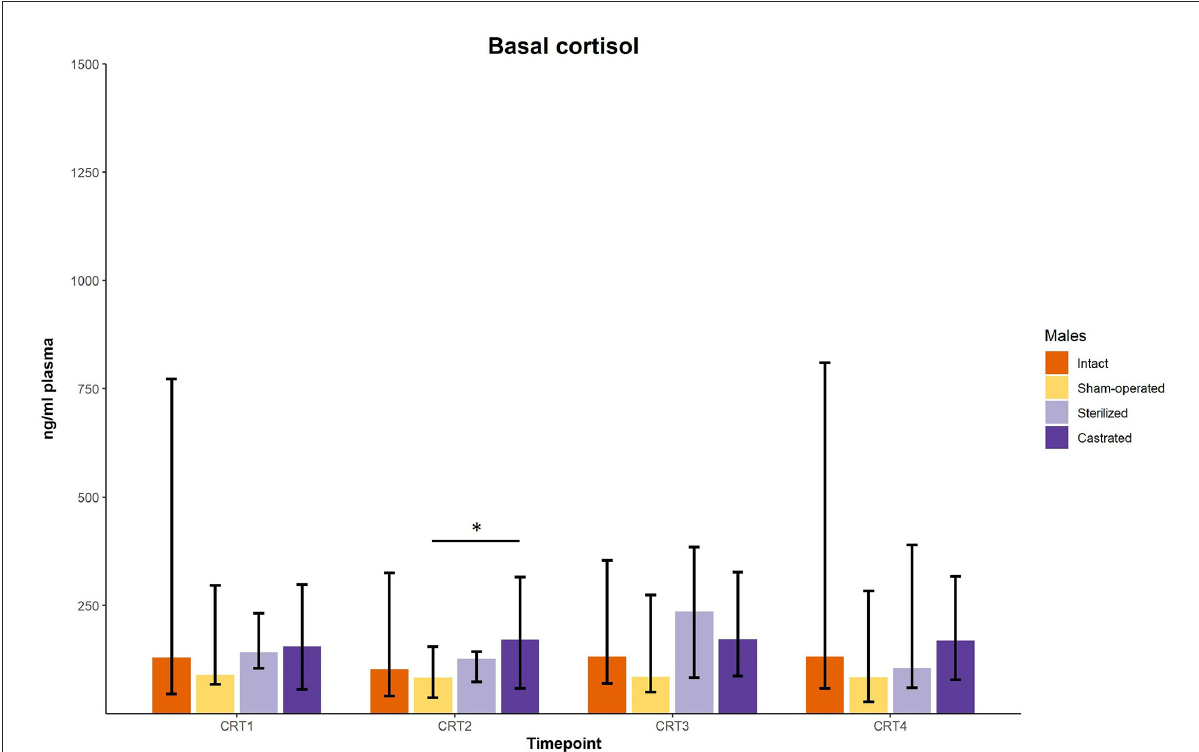
FIGURE3 Baseline cortisol concentrations in ng/ml plasma of intact, sham-operated, sterilized and castrated males during cortisol response tests. Data are presented as medians, minimum, and maximum values. CRT1, cortisol response test before surgery; CRT2, cortisol response test about 4 days before start of experiment (1 male and 2 females were put together); CRT3, cortisol response test 1 week after start of experiment; CRT4, cortisol response test 2 weeks after start of experiment. Statistics: Kruskal-Wallis tests, post-hoc Holm-Bonferroni corrected Mann-Whitney U -Tests. N intact = 10, n sham − operated = 8, n castrated = 14, n sterilized = 4. * p < 0.05 (after Holm-Bonferroni